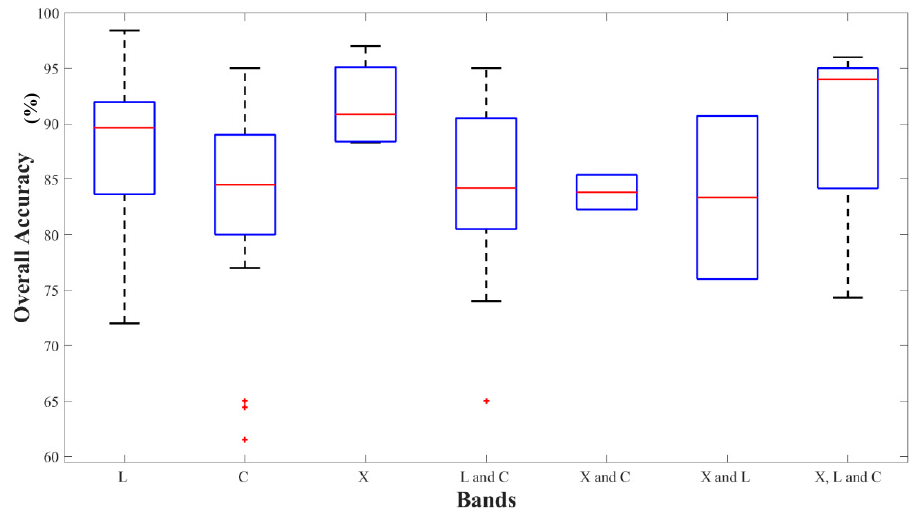
Figure 13. Box-and-whisker plots illustrating the effect of frequency bands on overall accuracy. Box limits show the 25 and 75 percentiles; whiskers demonstrate the maximum and minimum values (except for outlier dots in C and L bands); red lines within the boxes indicate the median.